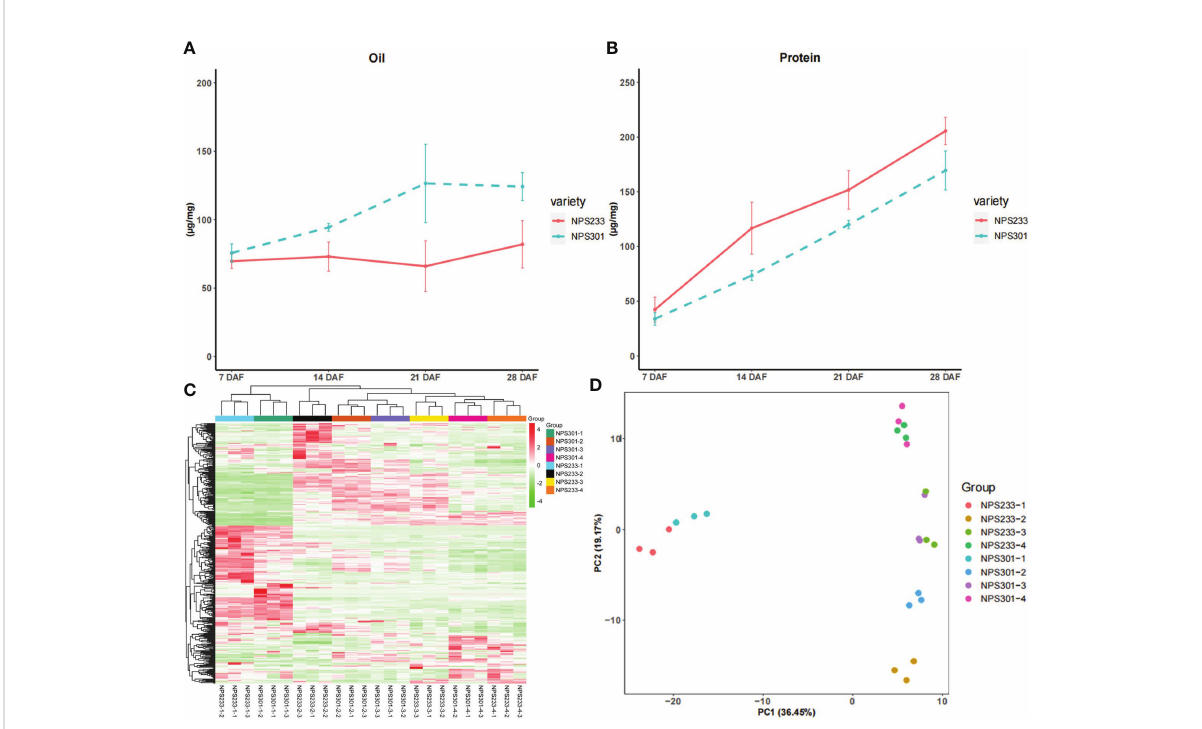
FIGURE 1 Phenotypic difference and 392 detected metabolites between ‘ NSP233 ’ and ‘ NPS301 ’ . (A) Protein content of 7 DAF, 14 DAF, 21 DAF and 28DAF. (B) Oil content of 7 DAF, 14 DAF, 21 DAF and 28 DAF. (C) The hierarchical clustering analysis of the 24 soybean seed samples. (D) Principal component analysis of the seed samples, each circle represents a sample. For hierarchical clustering analysis, normalized signal intensities of metabolites (unit variance scaling) are visualized as a color spectrum.7 DAF, NPS233-1 and NPS301-1; 14 DAF, NPS233-2 and NPS301-2; 21